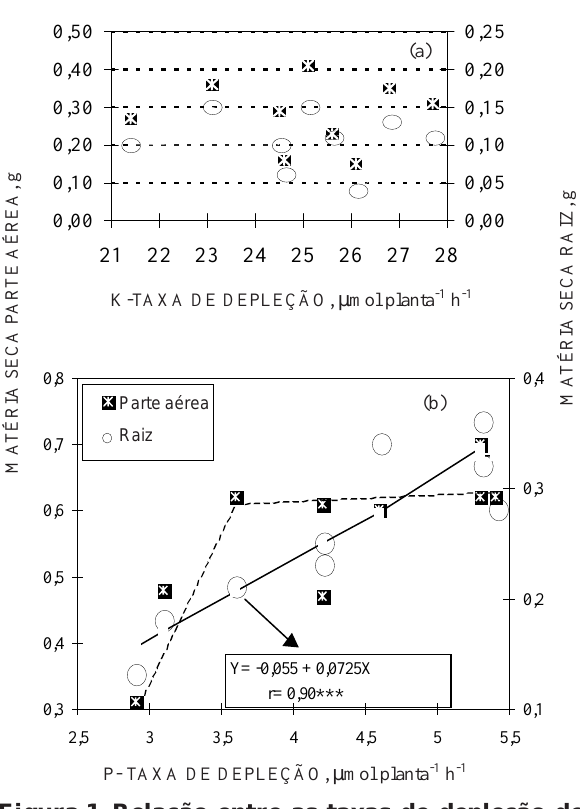
Figura 1. Relação entre as taxas de depleção de potássio e de fósforo por três cultivares de sorgo, cujas sementes foram peletizadas ou não com calcário e com termofosfato magnesiano e suas respectivas massas da matéria seca da parte aérea e das